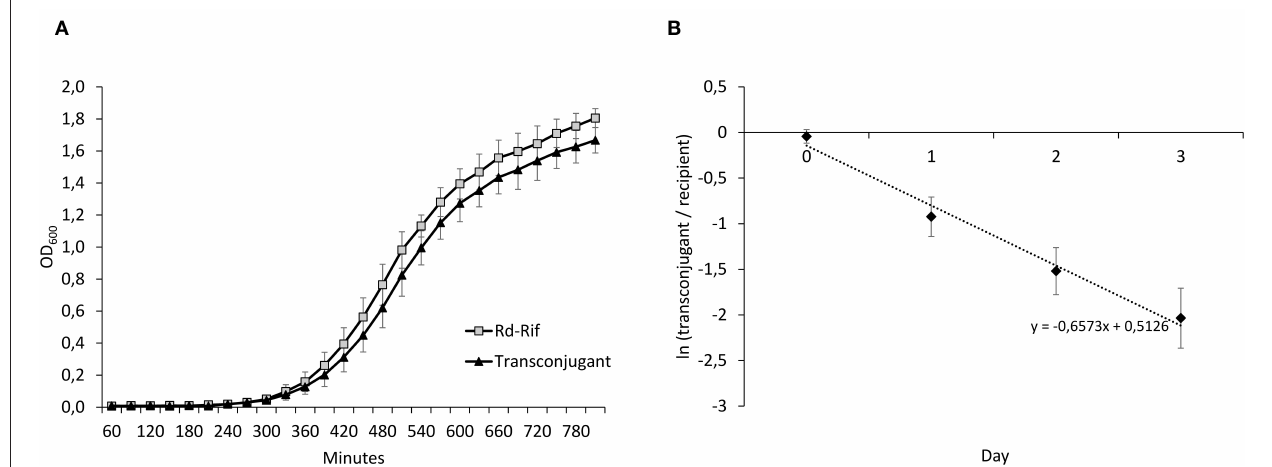
FIGURE 5 | (A) Growth curves of Rd-Rif and the transconjugant. (B) Results from head-to-head competition experiments between Rd-Rif and the transconjugant, displaying changes in ln(transconjugant/recipient) over time. The average regression (dashed line) is displayed. The negative slope value reflects a fitness cost of Tn 7100 . This was confirmed by calculations of relative fitness ( w ) of the transconjugant ( w = 0.90, p = 0.002). Error bars indicate ± standard deviation.